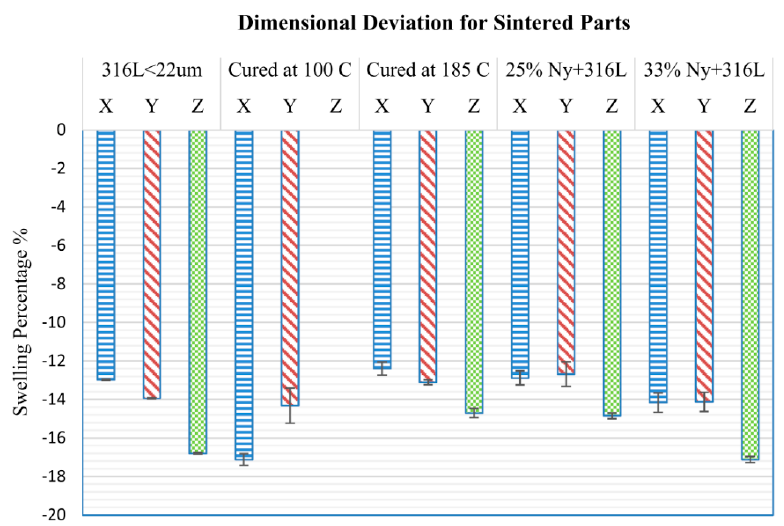
Figure 16. Dimensional deviation for X, Y, and Z directions for the sintered samples [106] .